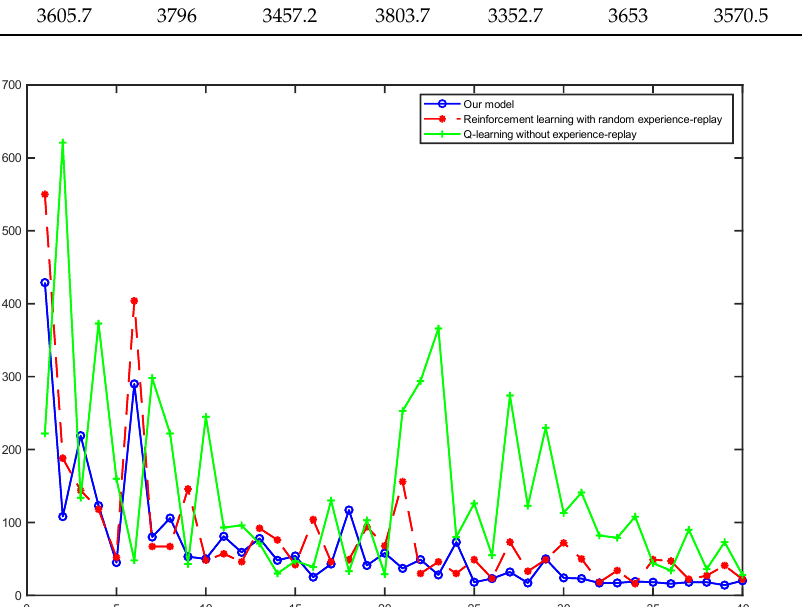
Figure 17. Comparison of steps of our model with two reinforcement learning models for a water maze experiment under the same conditions: The solid blue line represents our model, the red dotted line represents the reinforcement learning with random experience replay and the solid green line represents the Q-learning without experience replay.